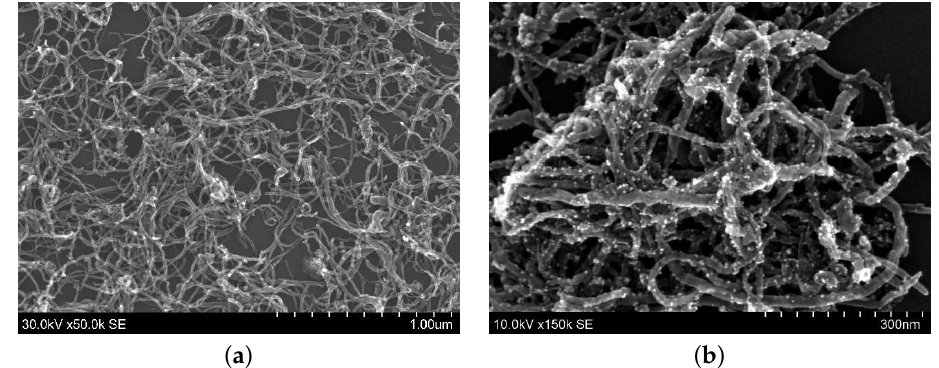
Figure 1. Images of MWCNTs before making tablets: ( a ) purified bundled MWCNTs; ( b ) purified bundled MWCNTs decorated with ZrO 2 nanoparticles, which are visible as light spots on the nanotube surface. Courtesy of Nanomaterials